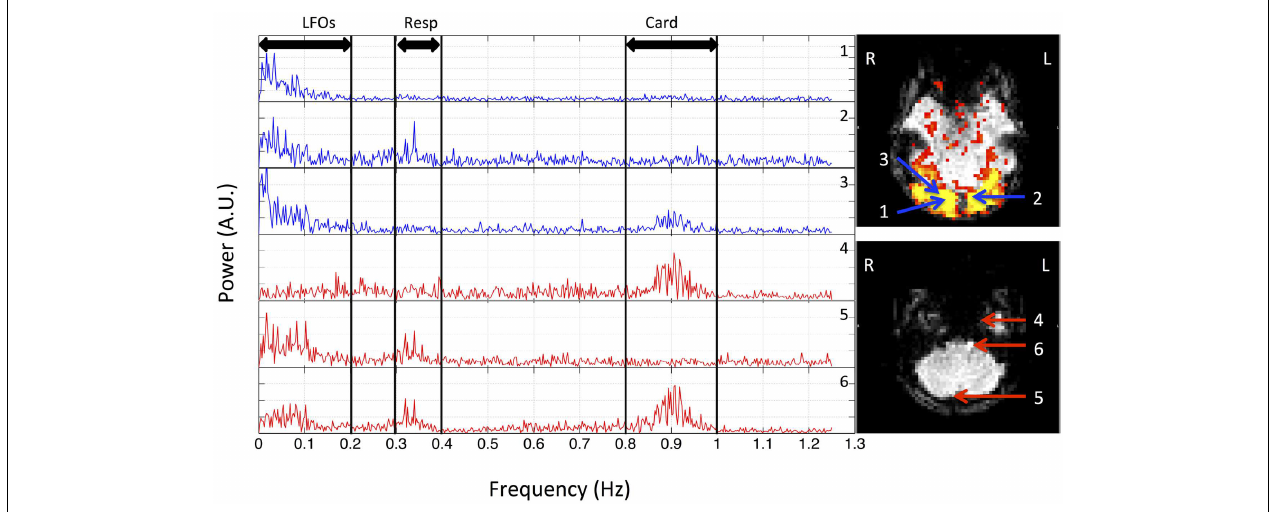
different physiological processes were marked.The two graphs on the right indicate the locations of these voxels in the visual cortex (top) and bottom slices (lower).